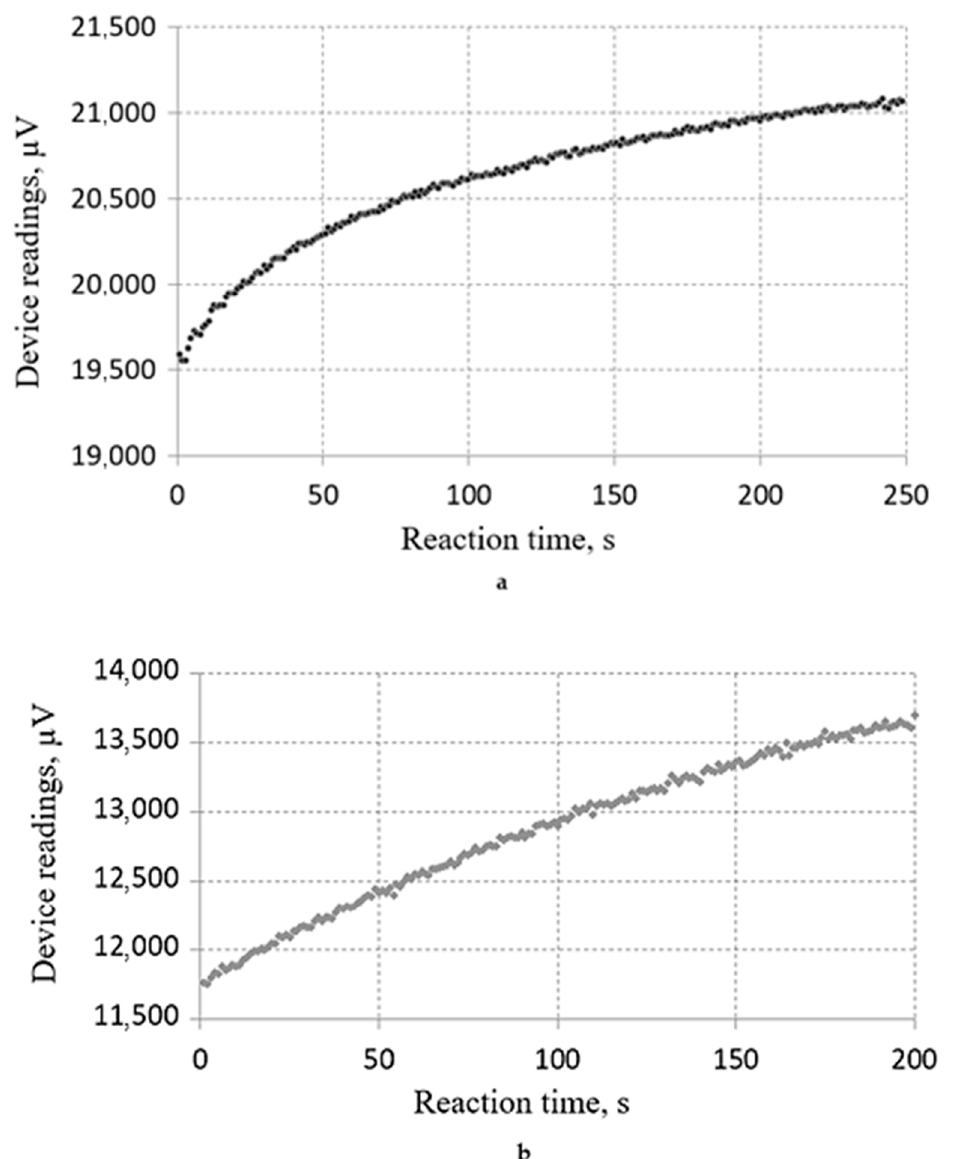
Figure 4. The signal-time dependencies of the methylene blue reduction by biofilm ( a ) and activated sludge from aerotank ( b ).